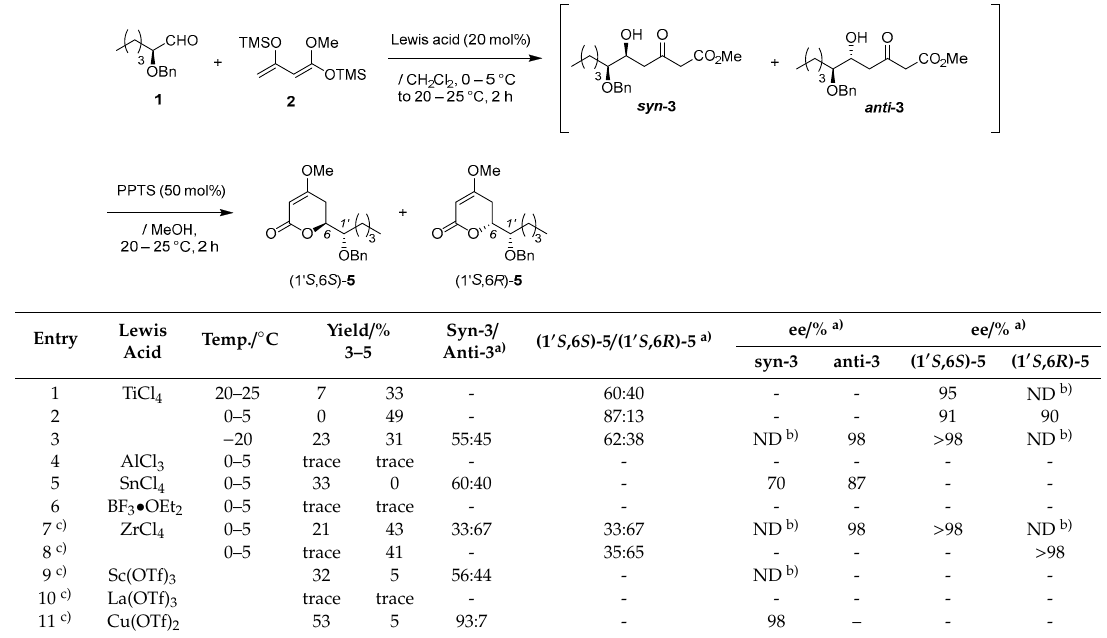
Table 1. Catalytic diastereoselective Mukaiyama aldol reaction.